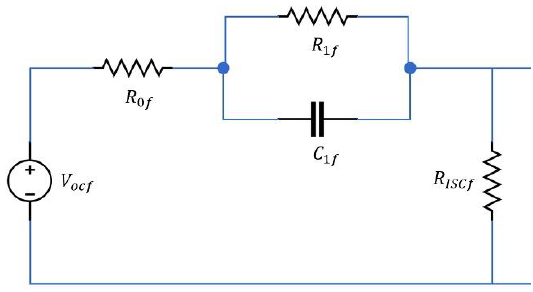
Figure 6. Configuration of simulation model: the first-order RC model with 𝑅 𝐼𝑆𝐶𝑓 .